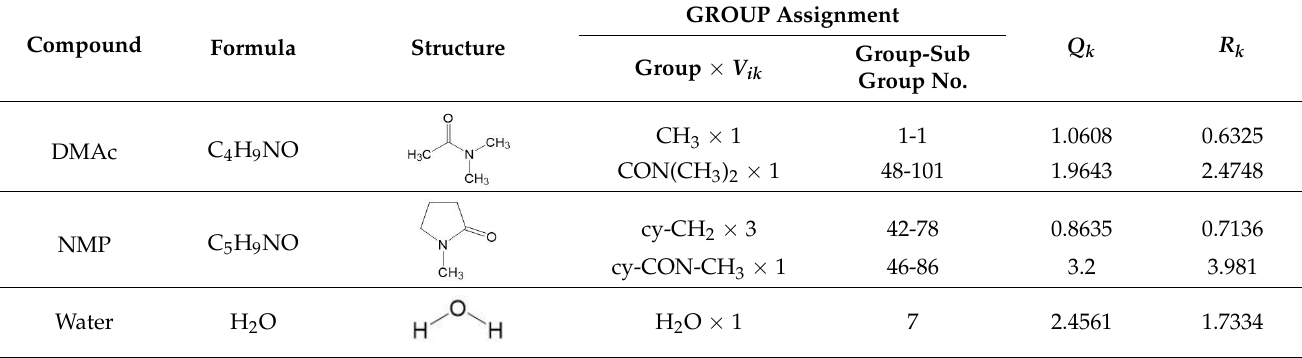
Table A2. Interaction parameters between UNIFAC groups.